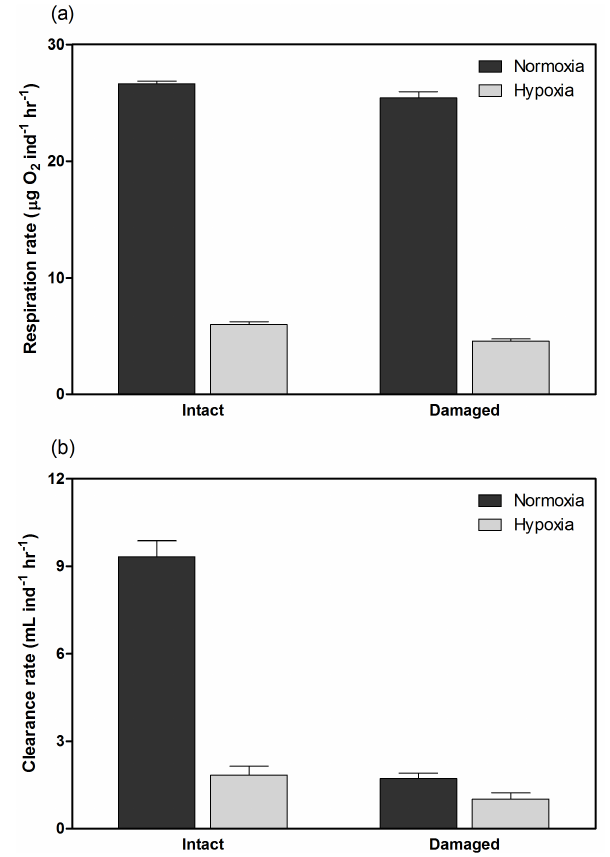
Figure 5. (a) Respiration rate and (b) clearance rate of H. diram- phus in different treatments (mean + S.E.; n = 5).